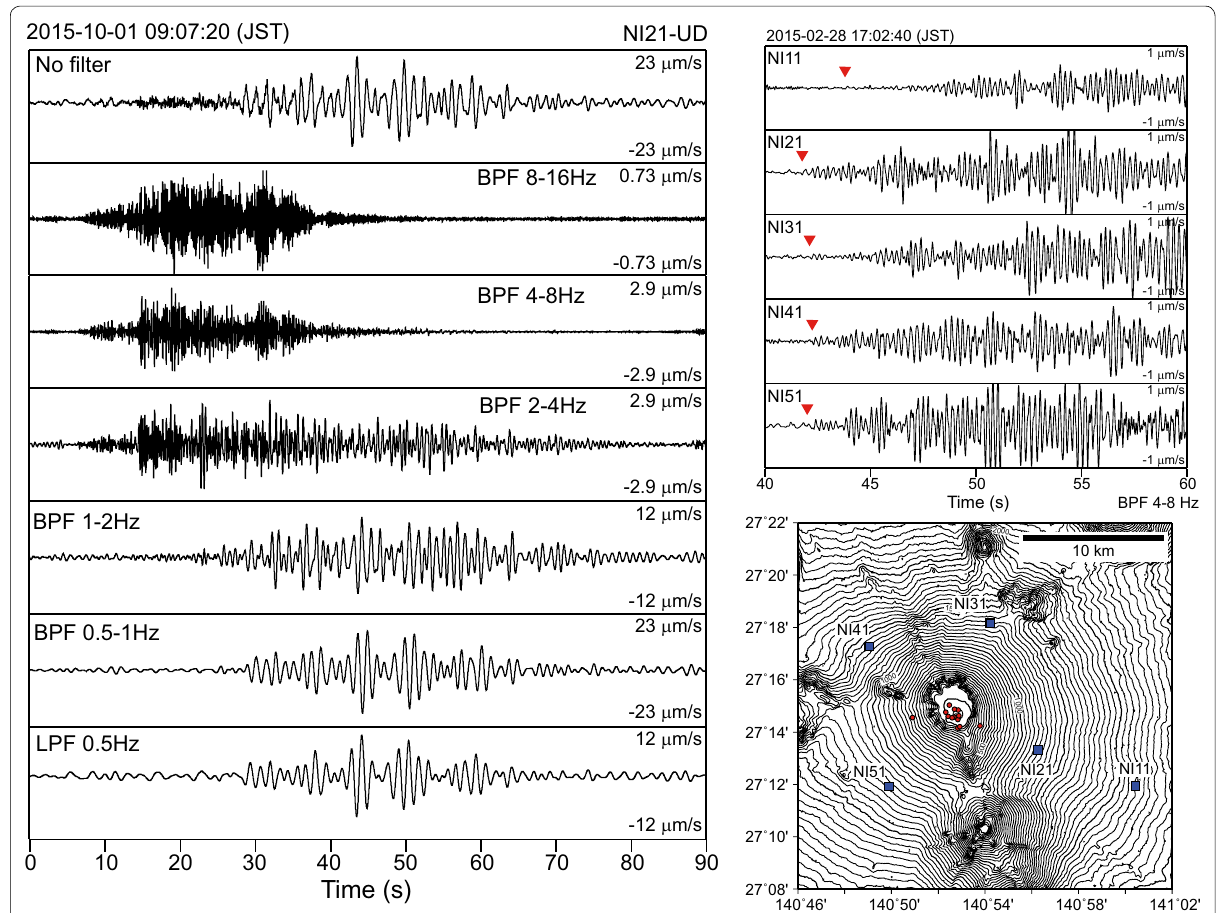
Fig. 2 Seismic records for events collected by LT-OBSs deployed near Nishinoshima (left and upper right) and obtained epicenters for the events (lower right). Left: waveforms of typical characteristic events recorded by NI21. A waveform without filtering (uppermost) and with bandpass filter- ing of various frequency bands (lower) are shown. Traces indicate ground velocity, and scales are shown on the right corners of each trace. The small-amplitude high-frequency component arrives early, followed by large-amplitude waves with a period of a few seconds. Data with a frequency band of 4–8 Hz have the highest S/N ratio. Upper right: bandpass-filtered (4–8 Hz) records of the event recorded with LT-OBSs. The event occurred during the first-term observation and records from all LT-OBSs are shown. Red inverted triangles denote first arrivals. NI11 has the latest arrival among the stations. Lower right: red circles and blue squares show epicenters and positions of LT-OBSs, respectively. Epicenters of the events are concentrated in